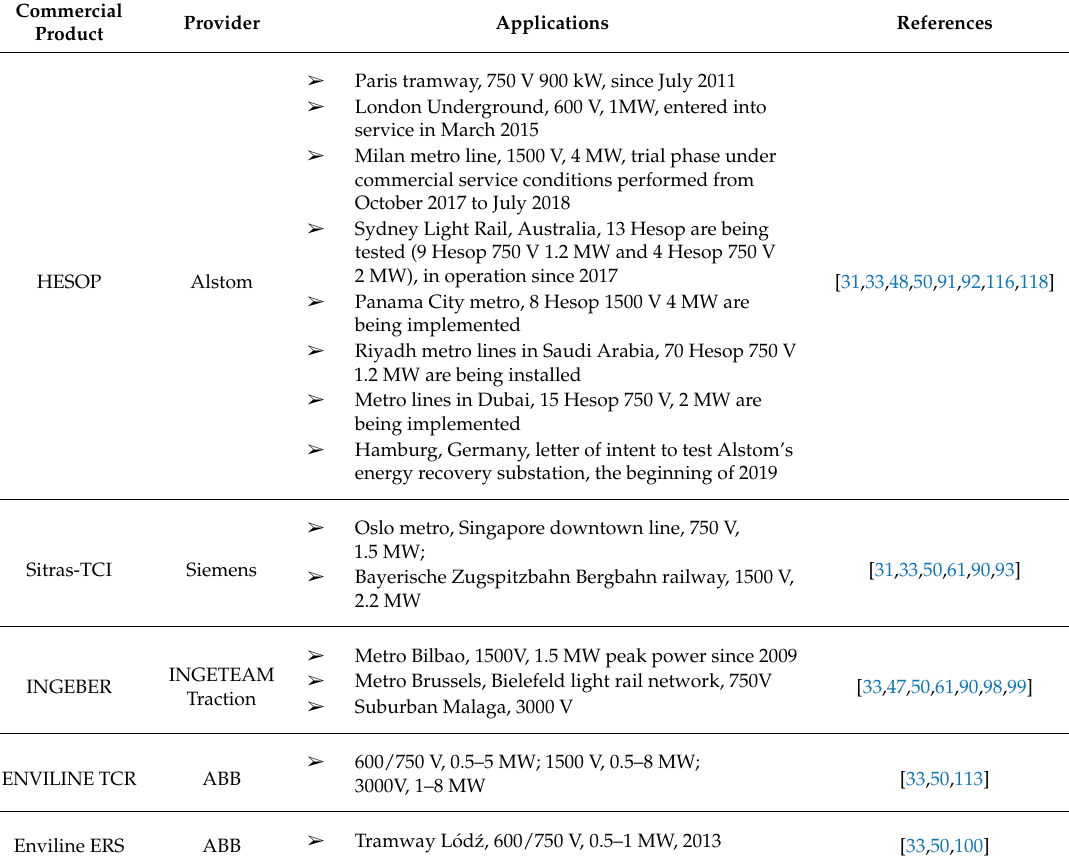
Table 3. Main commercial solutions for the implementation of reversible DC traction